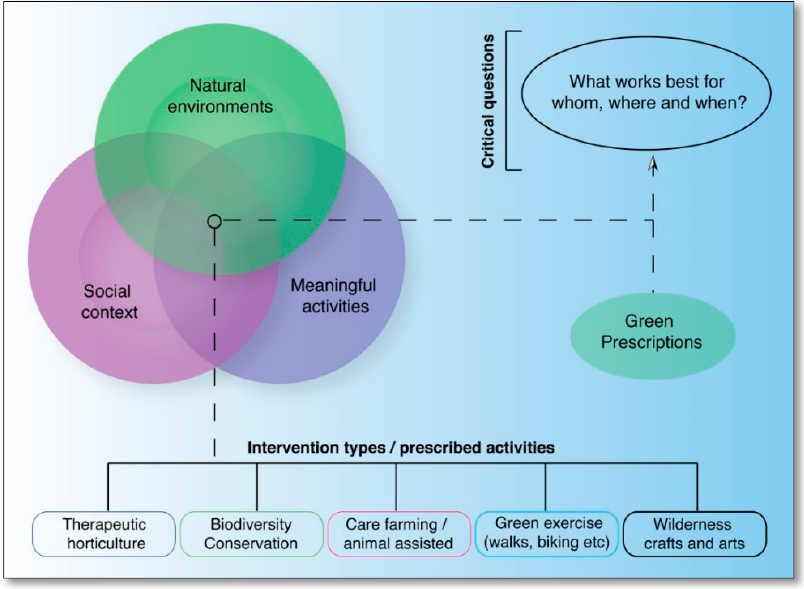
Figure 2. The interaction of the social context, natural environments and meaningful activities, and the potential types of nature-based interventions (created by the authors, partially adapted from [9]).